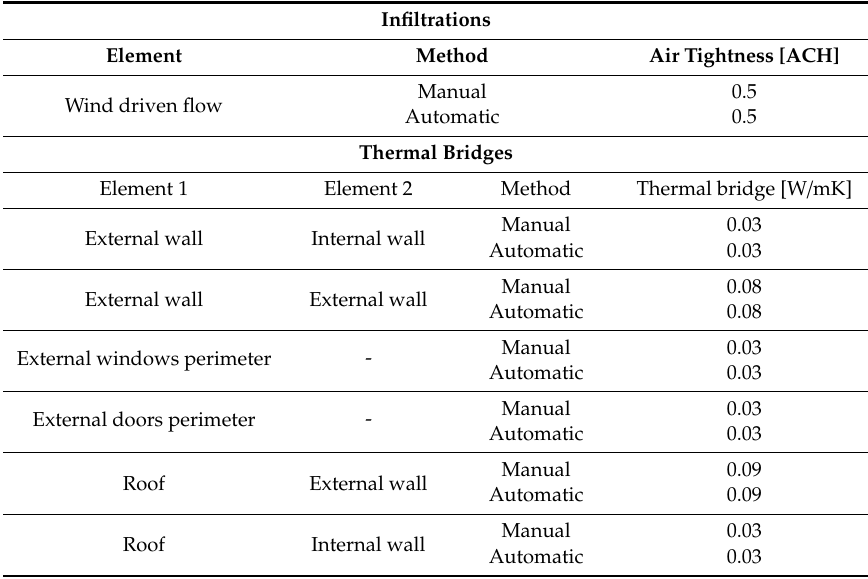
Table 12. Infiltration and thermal bridges input for resulting model from manual and automatic calibration (bold when changed).